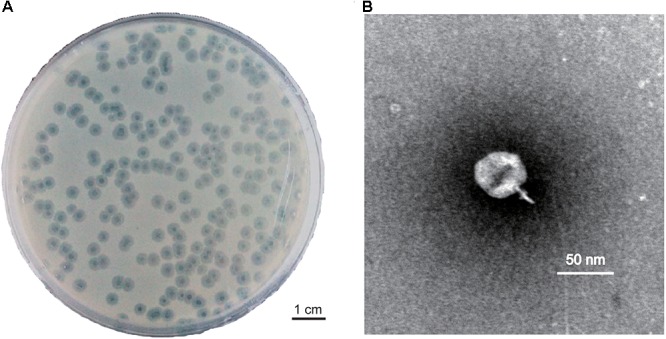
Plaque and TEM morphology of phages. (A) Plaque morphologies of phage PD-6A3. Scale bar, 1 cm. (B) TEM morphology of phage PD-6A3. Scale bar, 50 nm. PD-6A3, a novel Acinetobacter baumannii Phage. TEM, transmission electron micrograph.